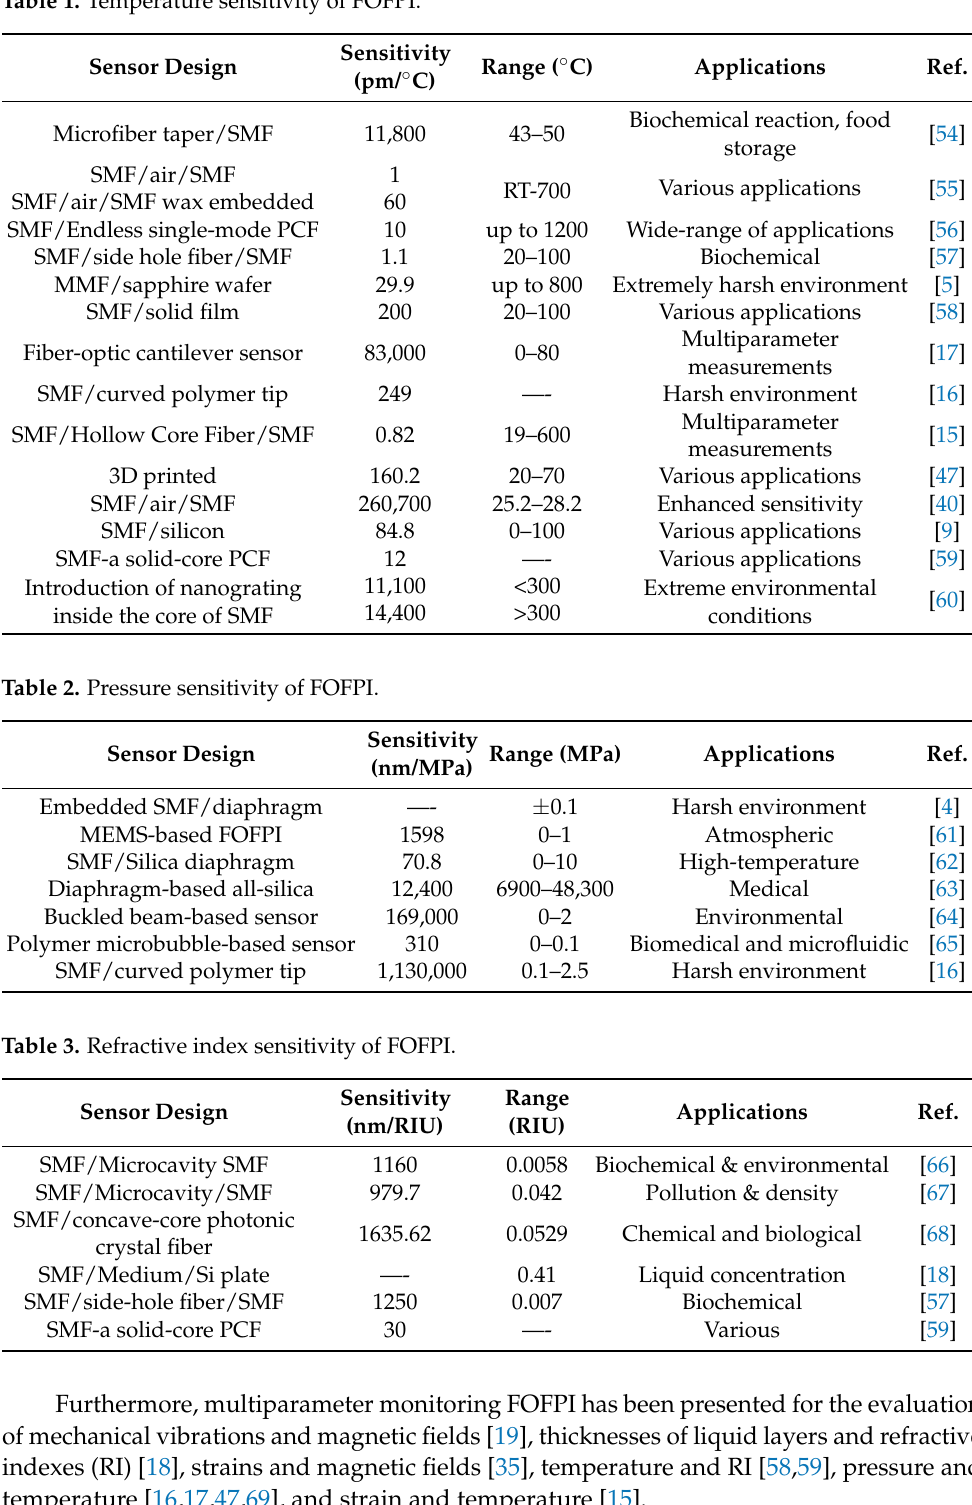
Table 1. Temperature sensitivity of FOFPI.